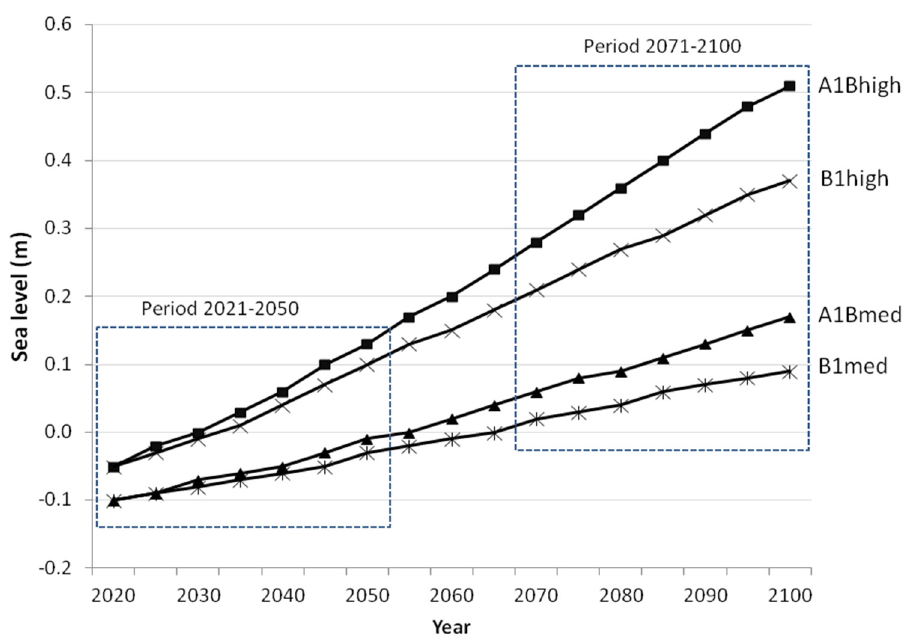
Figure 3. Average predicted sea level in the Hanko area according to the A1B and B1